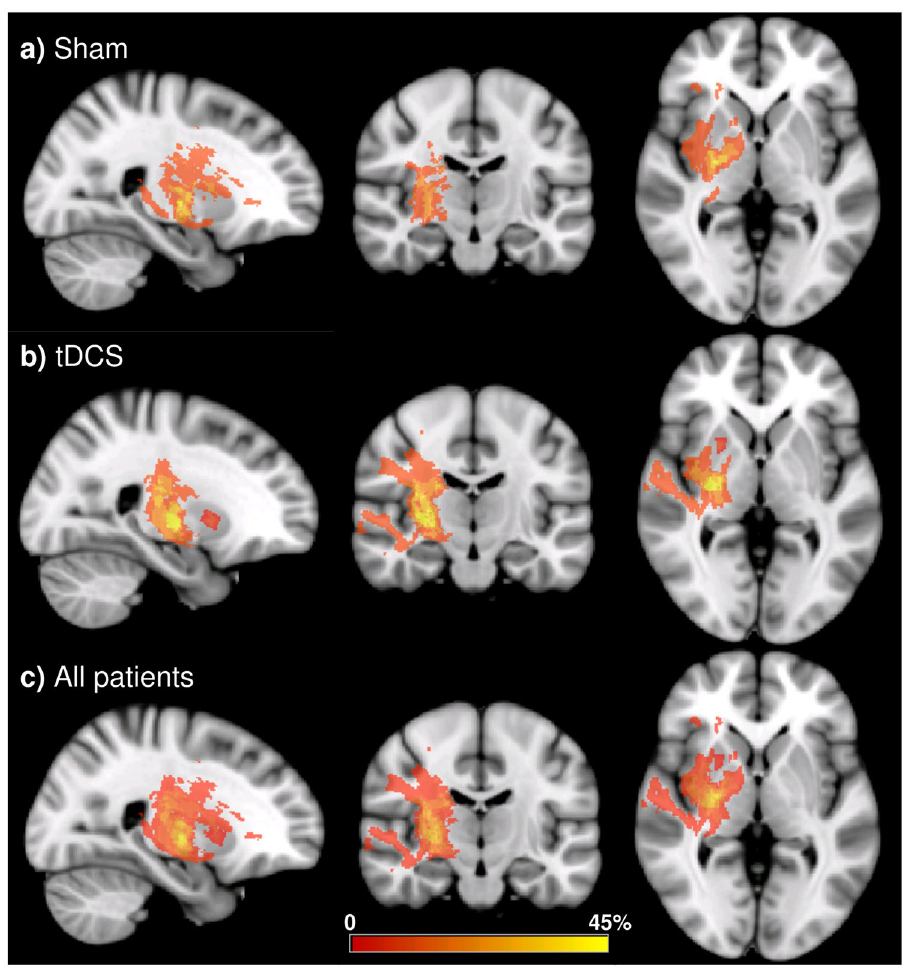
Figure 2. Incidence maps of lesion. The overlapping proportion of lesions from ( a ) the sham group, ( b ) the tDCS group, and ( c ) all patients combined, overlaid on the FMRIB58_FA template. Red and yellow colors denote low and high frequency of